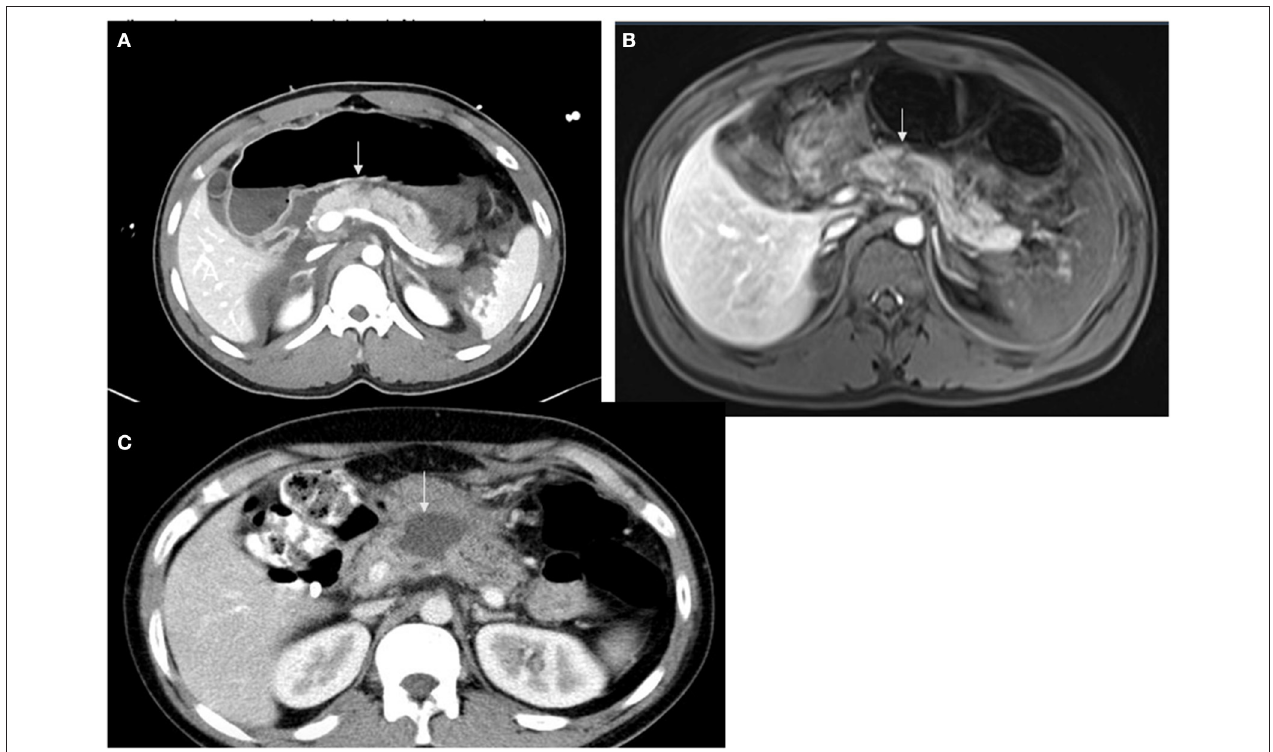
FIGURE 2 | Examples of radiologic findings of pancreatic injury in the study cohort using CT scan and MRI. (A) Axial CT in a patient with pancreatic laceration noted at the superior aspect of the body anterior to the spine involving approximately 50% of pancreatic craniocaudal dimension (white arrows), (B) Axial MRI (same finding) T2: the junction between the head and body of the pancreas shows no enhancement in the dynamic phase representing pancreatic contusion. The pancreatic duct adjacent to the contusion area displays focal dilatation without ductal transection. (C) Axial CT shows